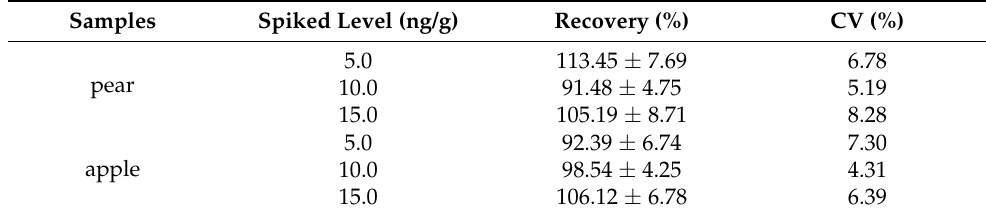
Table 4. Recovery rates of endosulfan in the pear and apple ( n =